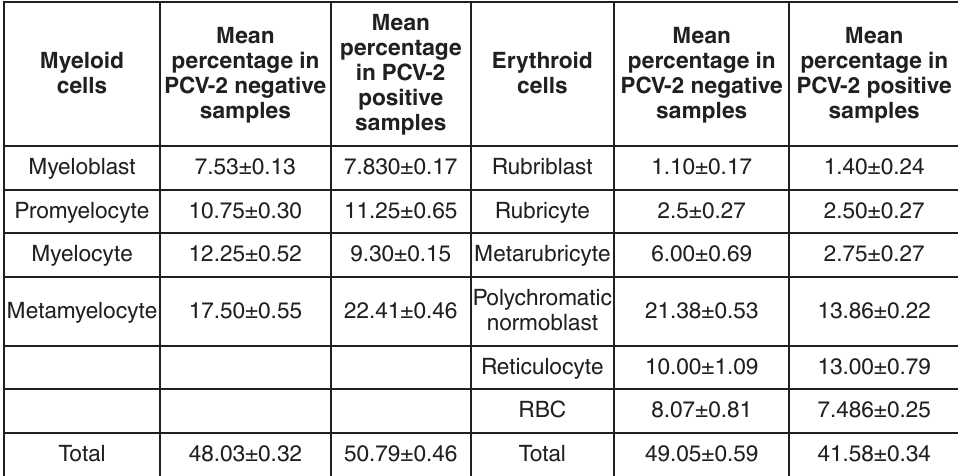
table 1. The mean cellular percentage of myeloid and erythroid precursors of bone marrow of